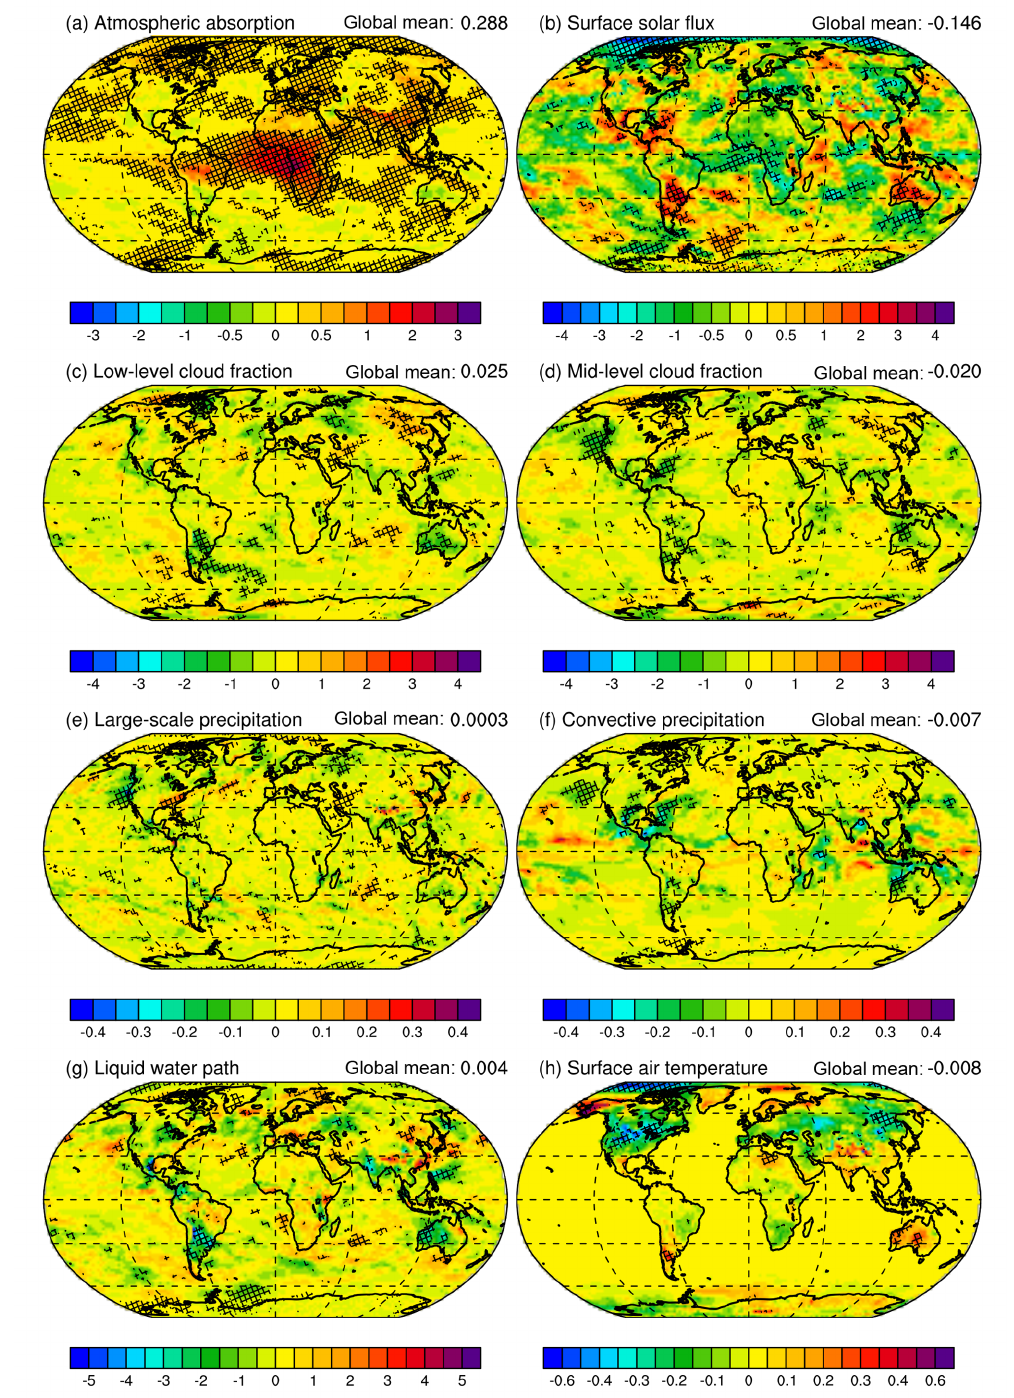
Figure 8. The effect of BrC addition in the BRC model run on (a) atmospheric absorption (Wm − 2 ), (b) surface solar flux (Wm − 2 ), (c) low- level cloud fraction (%; clouds below 700mb), (d) mid-level cloud fraction (%; clouds between 700 and 400mb), (e) large-scale precipitation (mmday − 1 ), (f) convective precipitation (mmday − 1 ), (g) liquid water path (gm − 2 ), and (h) surface air temperature ( ◦ K). Hatching indicates significance in ensemble year change to the 0.1